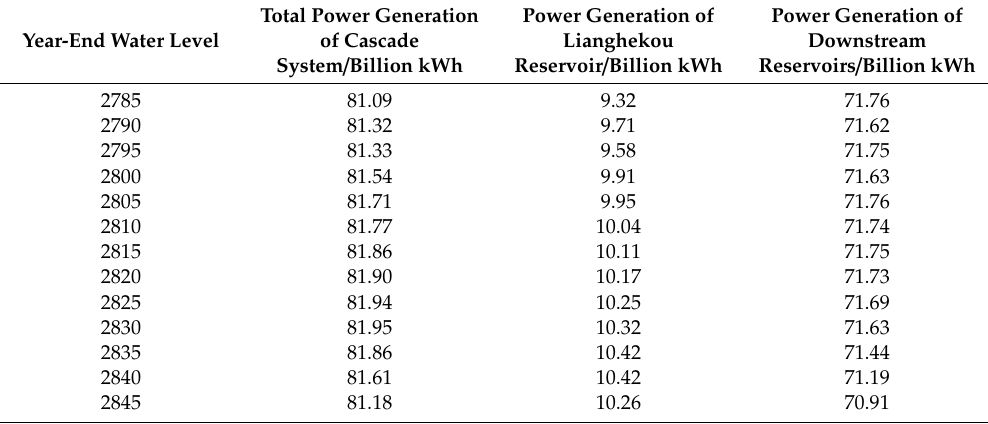
Table 7. Calculation results of the second dry year under di ff erent year-end water levels of Lianghekou